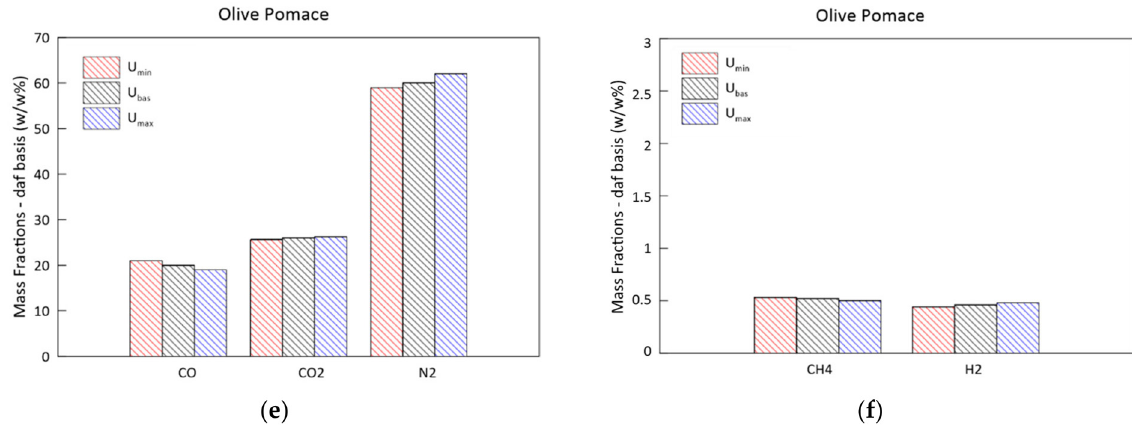
Figure 19. Species mass fractions (on a daf basis) at the reactor exit section for ( a , b ) woodchip case 1, ( c , d ) hydro-char from green waste, ( e , f ) olive pomace gasification at different biomass/residual material initial moisture content levels.